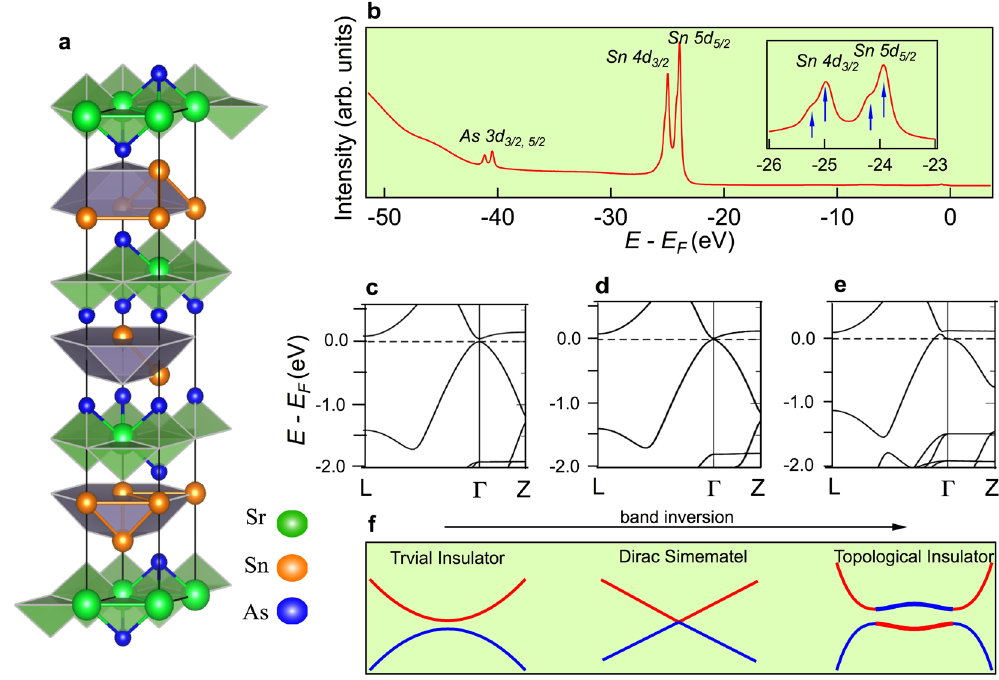
Figure 1. ( a ) Crystal structure of SrSn 2 As 2 . ( b ) Core level photoemission spectrum shows characteristic peaks of As and Sn. ( c ) and ( e ) Calculated bulk band structures with and without mBJ along high symmetry lines shows trivial band insulator and topological insulator state, respectively. ( d ) The critical point between ( c ) and ( e ) shows Dirac semimetal state. ( f ) Schematic of the band inversion mechanism in topological phase transition corresponding to ( c ) to ( e